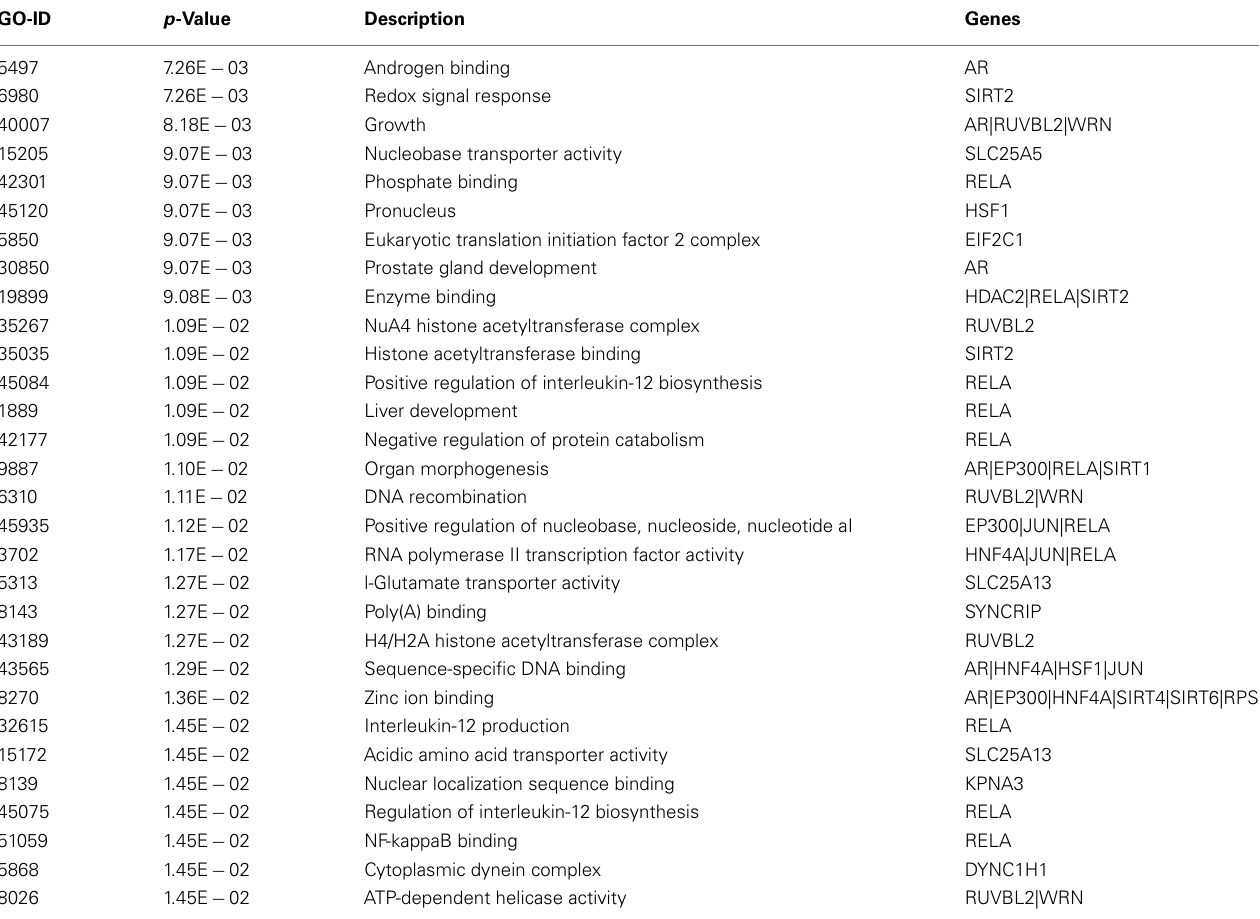
TableA2 | Biological processes associated with interacting proteins in the Sirt 1 interaction maps with significant p -value.